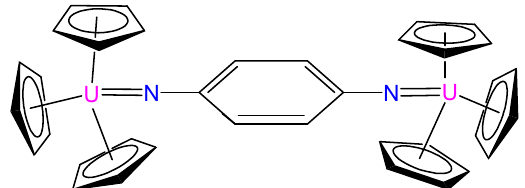
Figure 1. The diuranium(V) imido complex which exhibits AF U ⋅⋅⋅ U coupling [9].